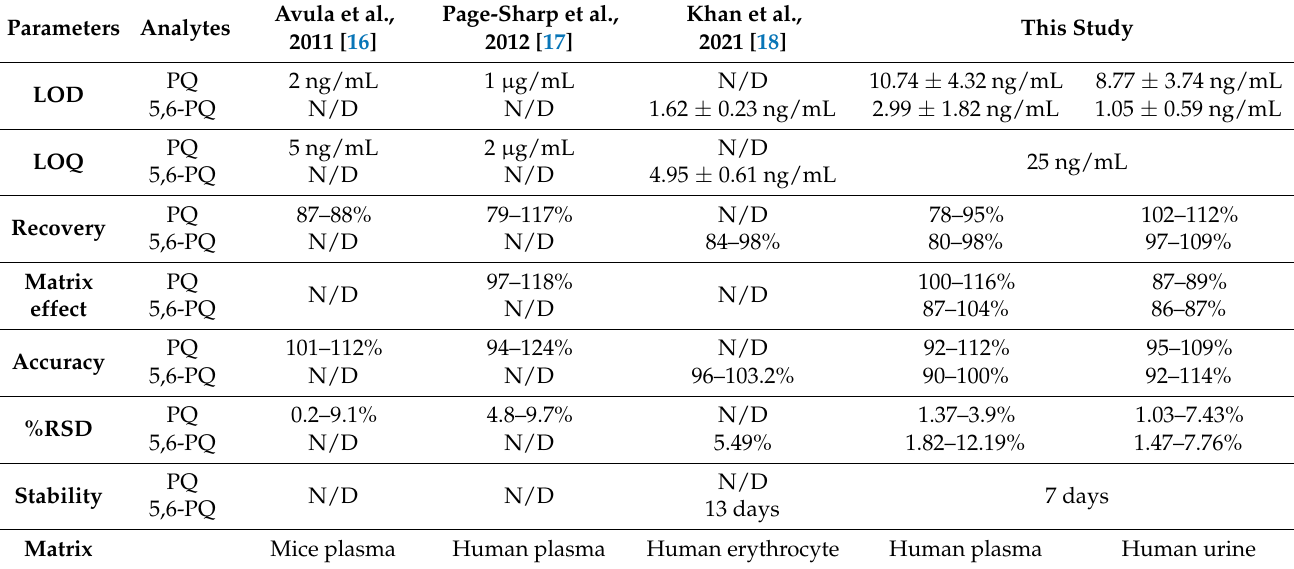
Table 5. Comparison of method validation parameters between this study and the